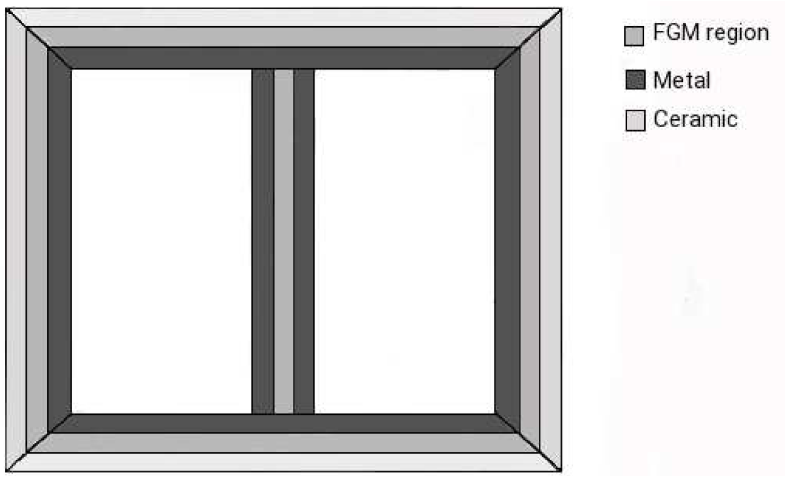
and σ ∗ yz = σ yz / σ yz . max max